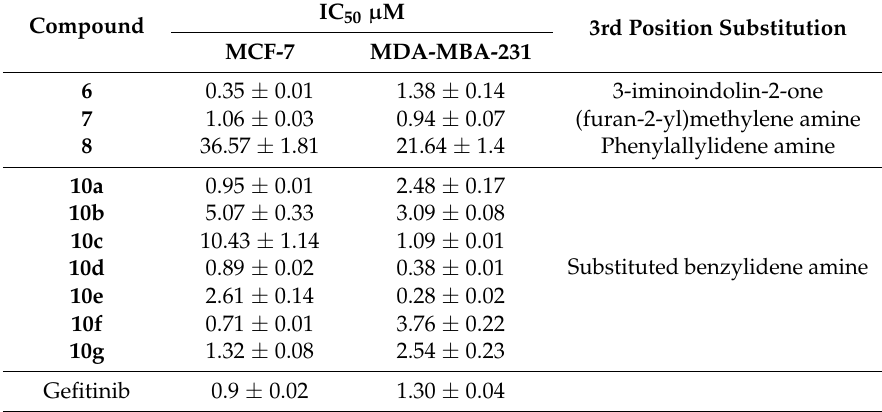
Table 1. IC 50 values for cytotoxic screening of title compounds against two cell lines (MCF-7) and (MDA-MBA-231).